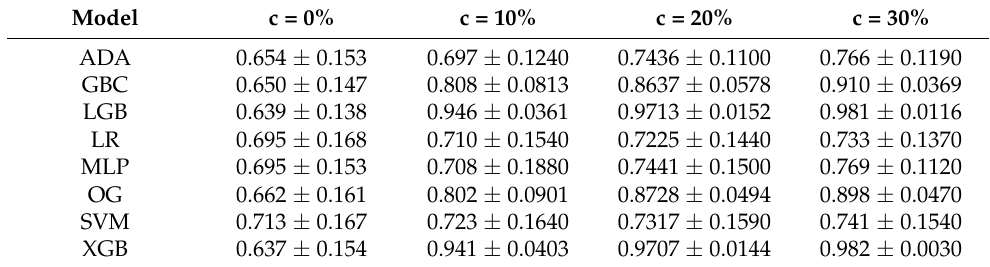
Table 6. Combined F1 scores ± standard deviations of the tested models for classifying participant positions as left-side lying, supine, or right-side lying.